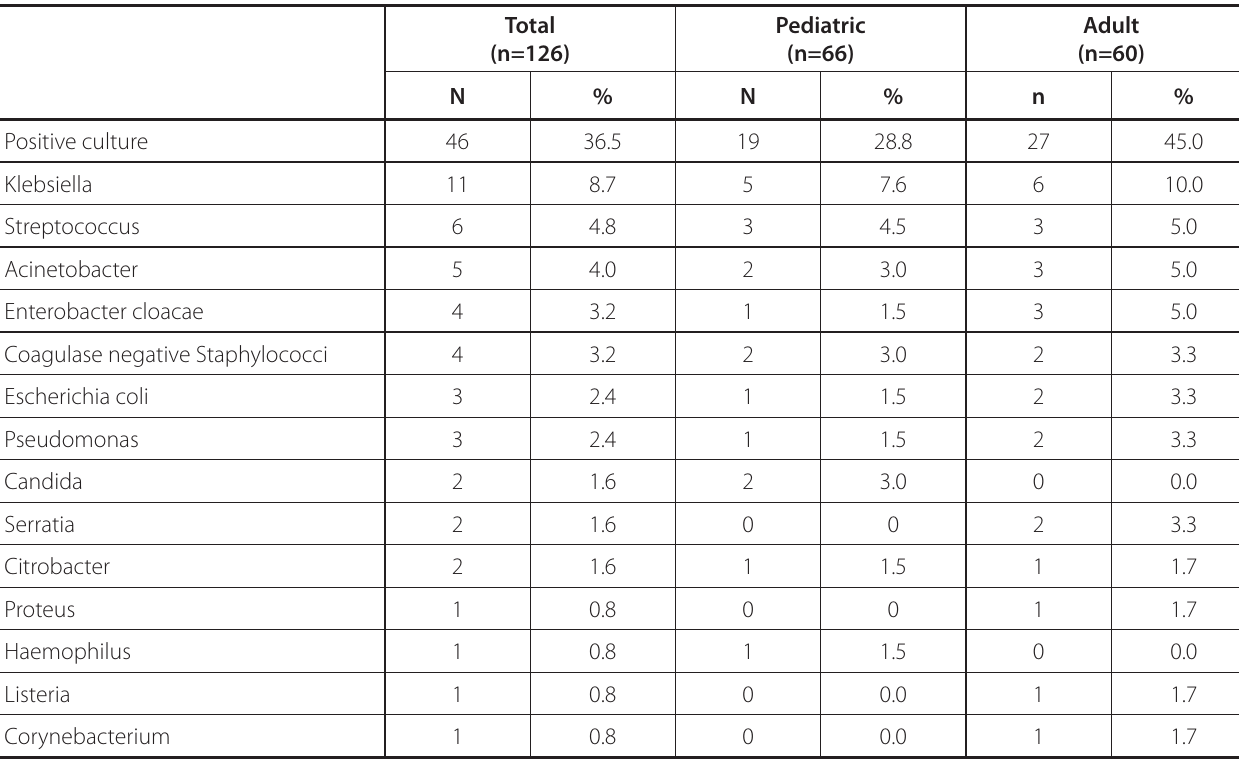
Table 4. Microorganisms in positive cultures.